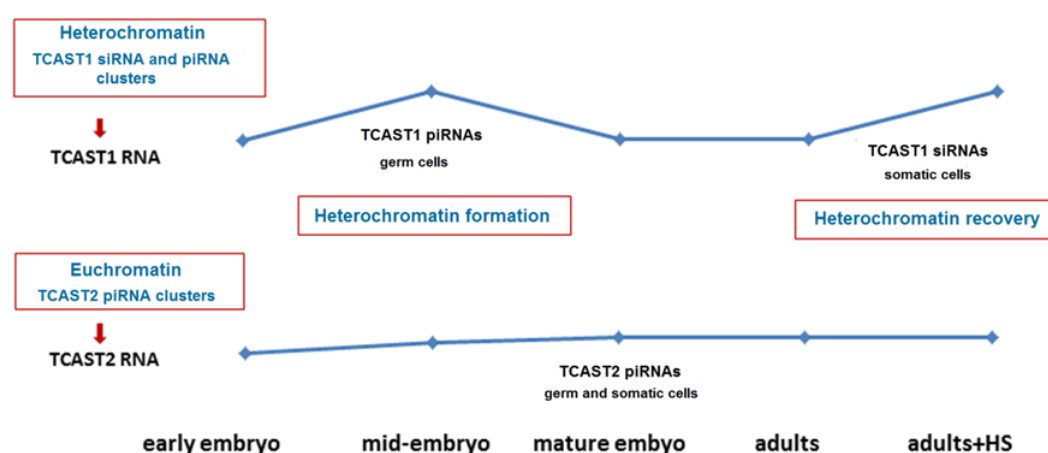
Figure 8. Proposed model that explains the distinct regulation of expression of TCAST1 and TCAST2 satellite DNAs during development and upon heat stress. The burst of TCAST1 transcripts occurs during mid-embriogenesis and the transcripts are predominantly processed into piRNAs, which are assumed to participate in heterochromatin establishment. During later development the processing of TCAST1 transcripts into siRNAs prevails and burst of transcripts upon heat stress (HS) is necessary for heterochromatin recovery. The transcription of TCAST2 RNA proceeds preferentially from euchromatic clusters and is stable during development, not specifically induced during mid-embryogenesis or upon heat stress. TCAST2 piRNAs, which are produced in germ and somatic cells, are assumed to play a role in the establishment and maintenance of euchromatic TCAST2 piRNA clusters, but not in the heterochromatin establishment or recovery. The level of TCAST1 and TCAST2 RNA during development is indicated by blue